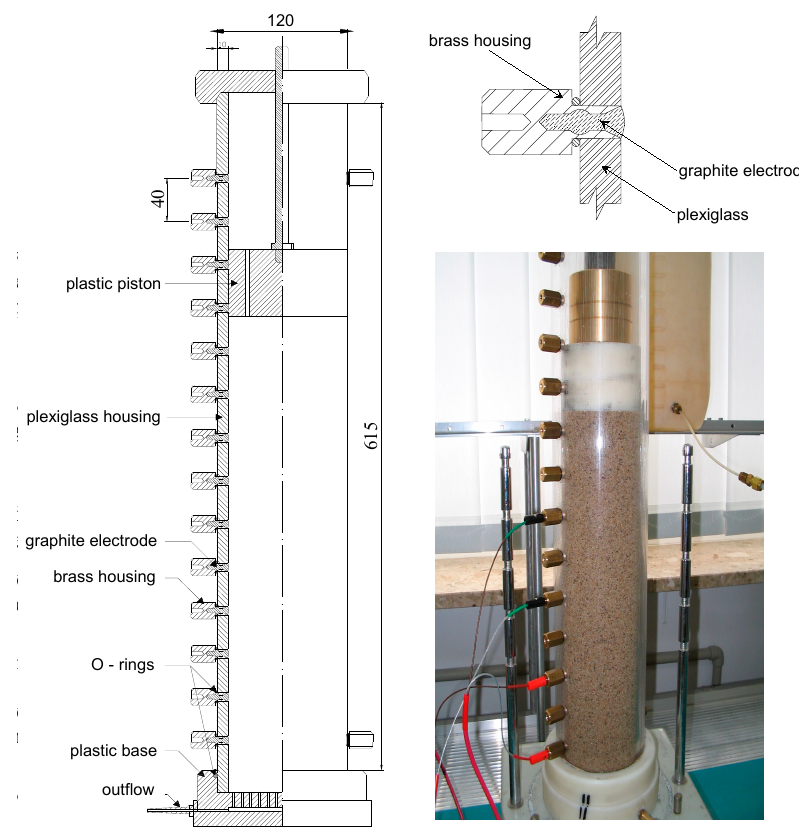
Figure 5. Column apparatus for measuring electrical resistivity of sands; scheme of apparatus and electrode and view of apparatus during sample preparation.